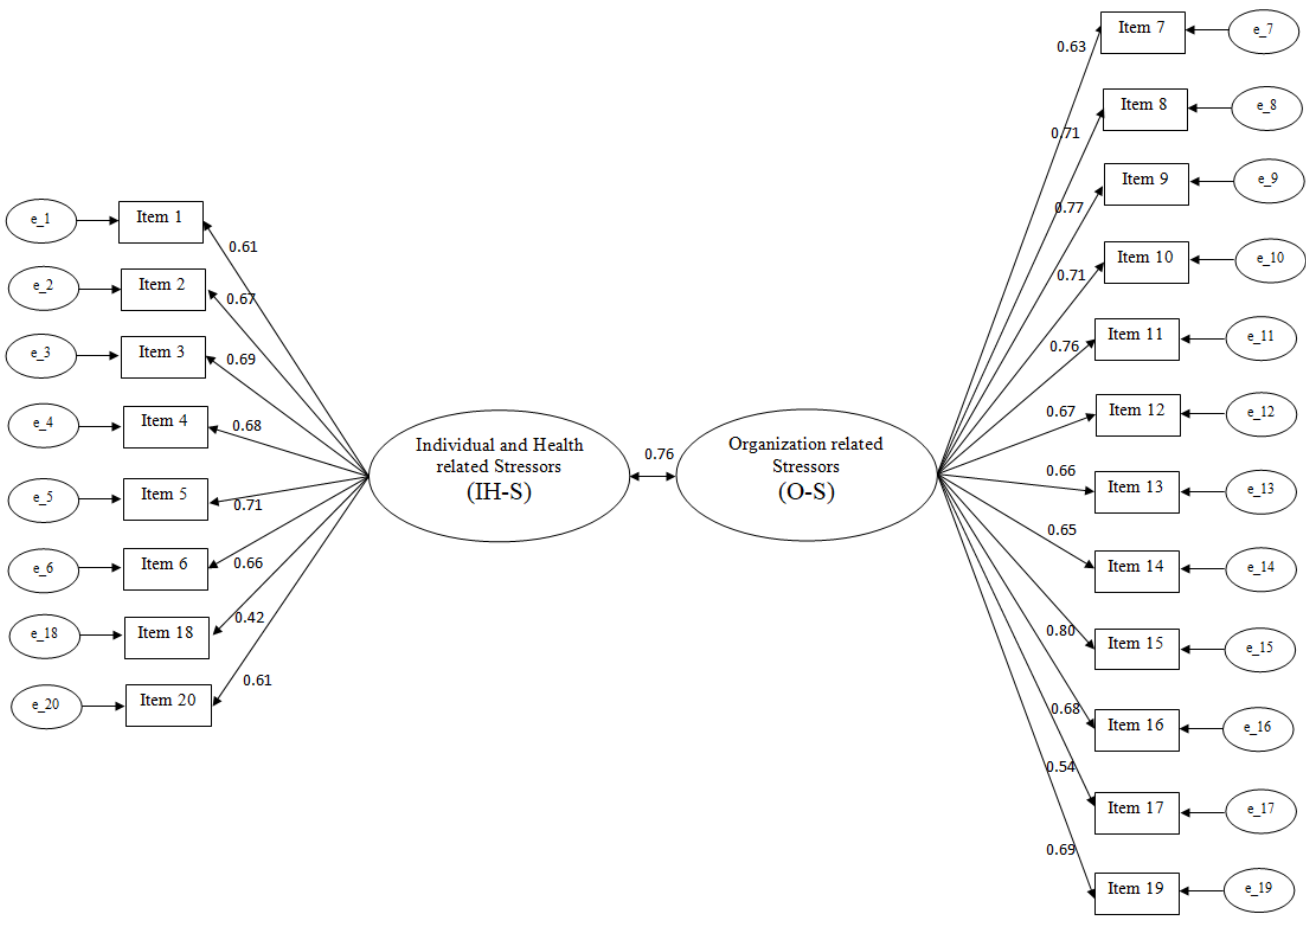
Figure 1. The two-factor model of the Individual- and Organization-related Stressors in Pandemic Scale for Healthcare Workers (IOSPS-HW) in T0 sample ( n = 950). Table 3. Pearson’s correlations between the Impact Events Scale-Revised (IES-R) score and the Individual- and Organization-related Stressors in Pandemic Scale for Healthcare Workers (IOSPS- HW) subscales and total